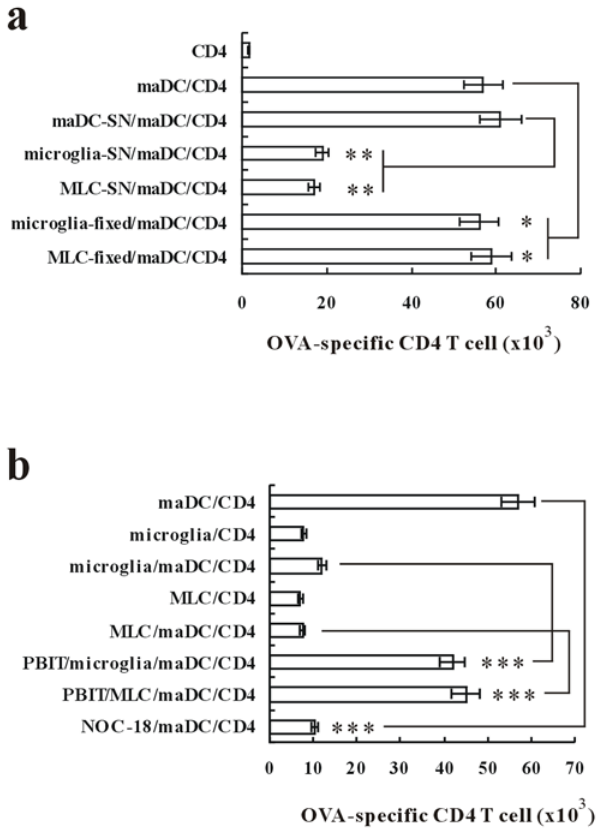
Figure 5. NO is involved in the immune inhibition by microglia and MLCs. (a) The inhibitory function of supernatants(SN) of microglia or MLCs cultured for 48 hours and paraformaldehyde-fixed microglia or MLCs were tested in the mDC/CD4 coculture system. (b) NO donor NOC-18 at a dosage of 40 m g/ml, NO synthetase inhibitor PBIT at a dosage of 20 m g/ml and neutralization antibodies against IL-10 were added into the maDCs/T cells coculture system and then the live CD4 T cells were detected by FACS. Data are presented as mean 6 s.d. of triplicate wells and representative of three independent experiments. * , P . 0.05; ** , P , 0.05; *** , P ,